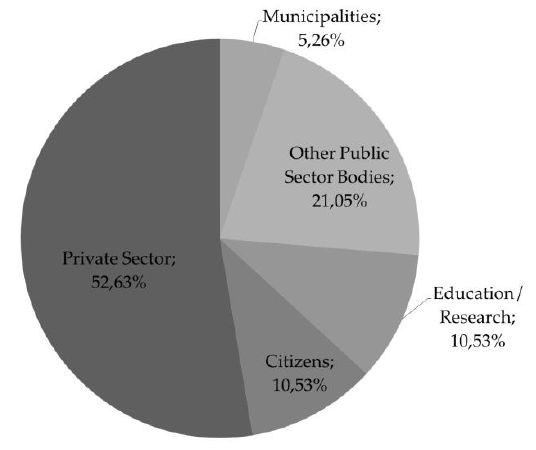
Figure 5. Types of Apps4Energy surveyed users as a percentage.